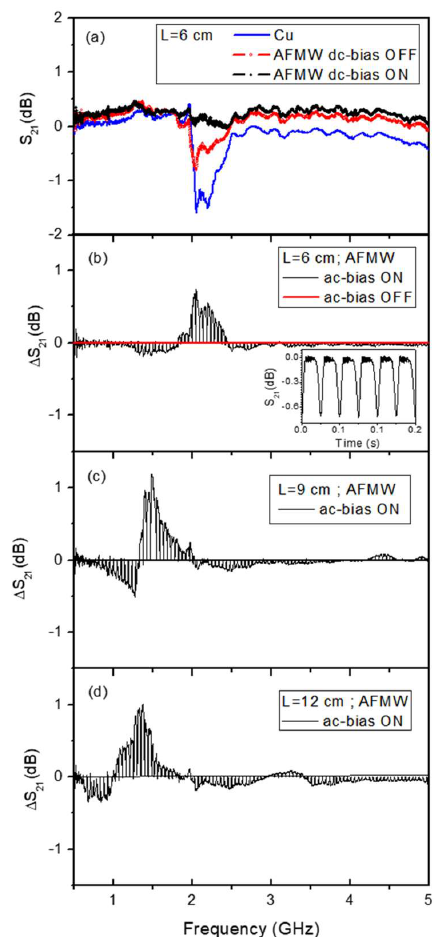
Figure 3. ( a ) Spectra of the transmission coe ffi cient ( S 21 parameter) in a frequency sweep between 0.5 and 5 GHz for a 6 cm length Cu microwire and a 6 cm length FeCoSiB microwire without bias field. ( b ) Modulation of the scattering coe ffi cient, ∆ S 21 , due to an AC-bias magnetic field with an amplitude of 15 Oe and a frequency of 20 Hz (solid black line). The horizontal red line represents the situation without magnetic field. This line is obtained after subtracting the signal in Figure 3a. The insert shows a S 21 time domain measurement at 2.1 GHz in FeCoSiB microwire with L = 6 cm. ( c , d ) ∆ S 21 modulation versus frequency measured with identical conditions than (a) for 9 cm and 12 cm length, respectively, FeCoSiB wires.